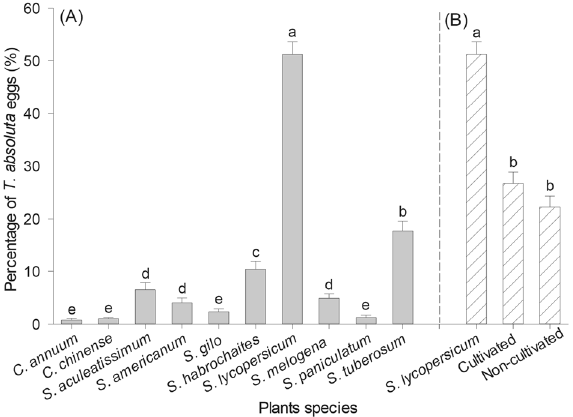
Figure 1. Percentage (mean ± SE) of eggs laid by T. absoluta females on leaves of different solanaceous plant species. ( A ) Comparison of all species of solanaceous plants tested here and ( B ) Comparison of tomato to cultivated and non-cultivated solanaceous plants. Means followed by different letters were significantly different according to the Scott Knott test ( p < 0.05).